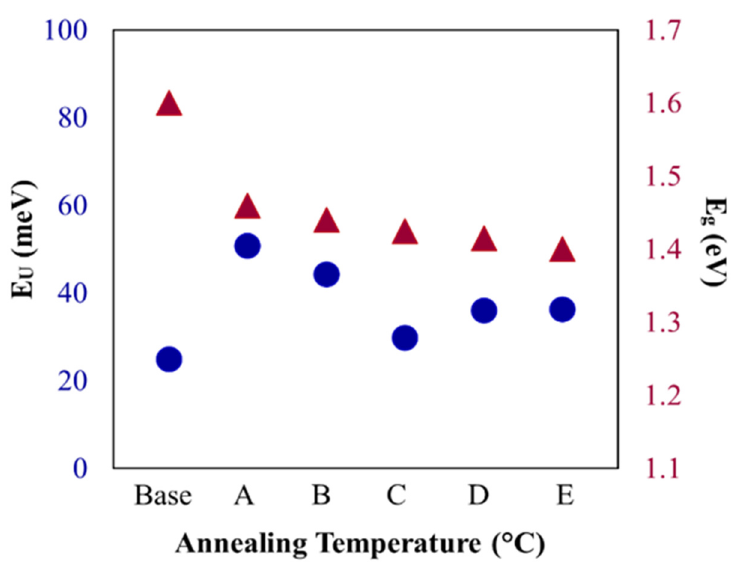
Figure 9. The relation between the bandgap energy and the Urbach tail of CdTe films.